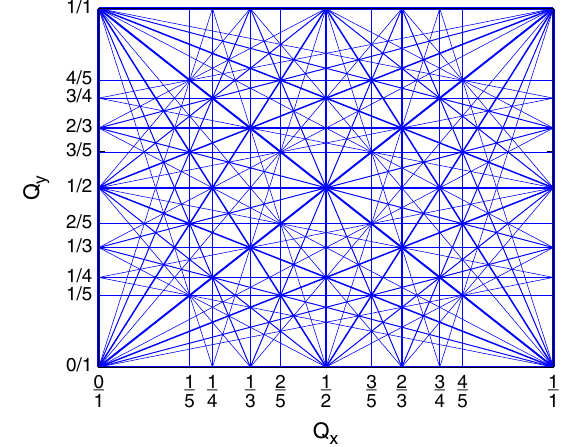
FIG. 1 (color online). Tune diagram displaying all resonances up to order 5 in the unitary square. The resonance lines cut the horizontal axis at the Farey fractions. The bundle of resonance lines of order N or lower converging in the point ð Q x ; Q y Þ ¼ ð h=k; 0 Þ (being h=k a